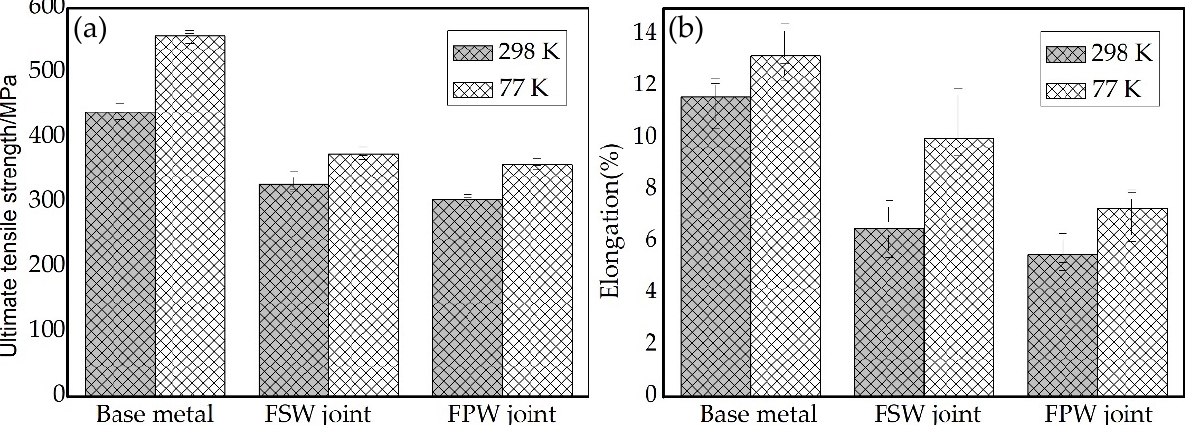
Figure 17. Tensile property of bass metal, FSW joints and FPW joints at 298 K and 77 K: ( a ) UTS and ( b ) elongation.